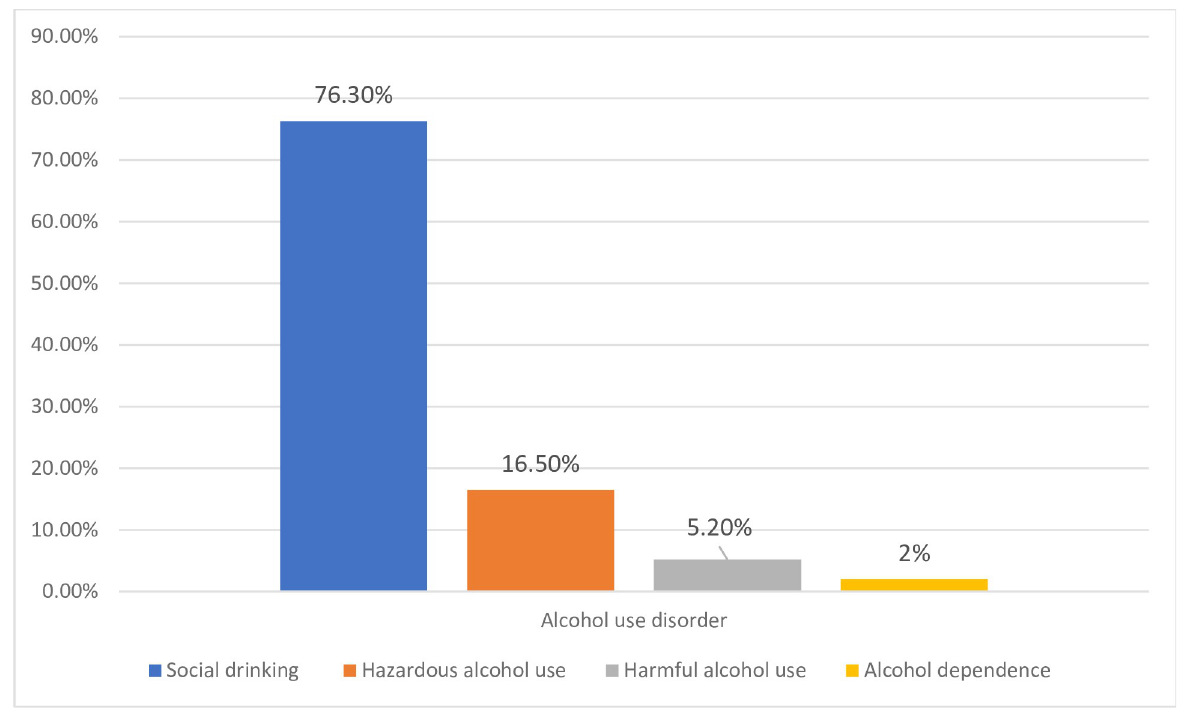
Fig 2. Bar chart showing that the level of alcohol use in adult residents of south Gondar zone, northwest Ethiopia, 2020 (N = 848).